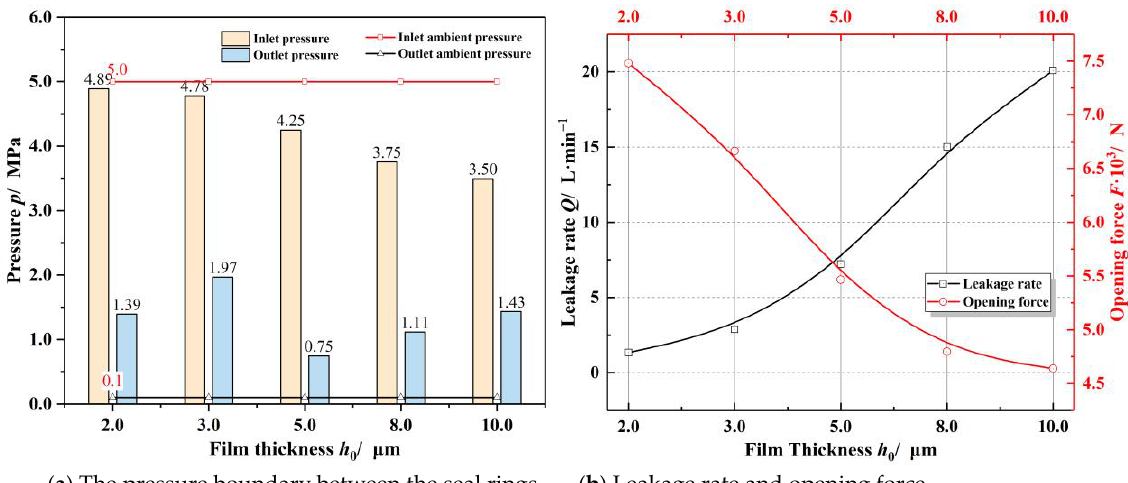
Figure 9. Influence of the basic film thickness on sealing performance ( ω = 20,000 r·min −1 , T o = 200 K, p o = 5.0 MPa).